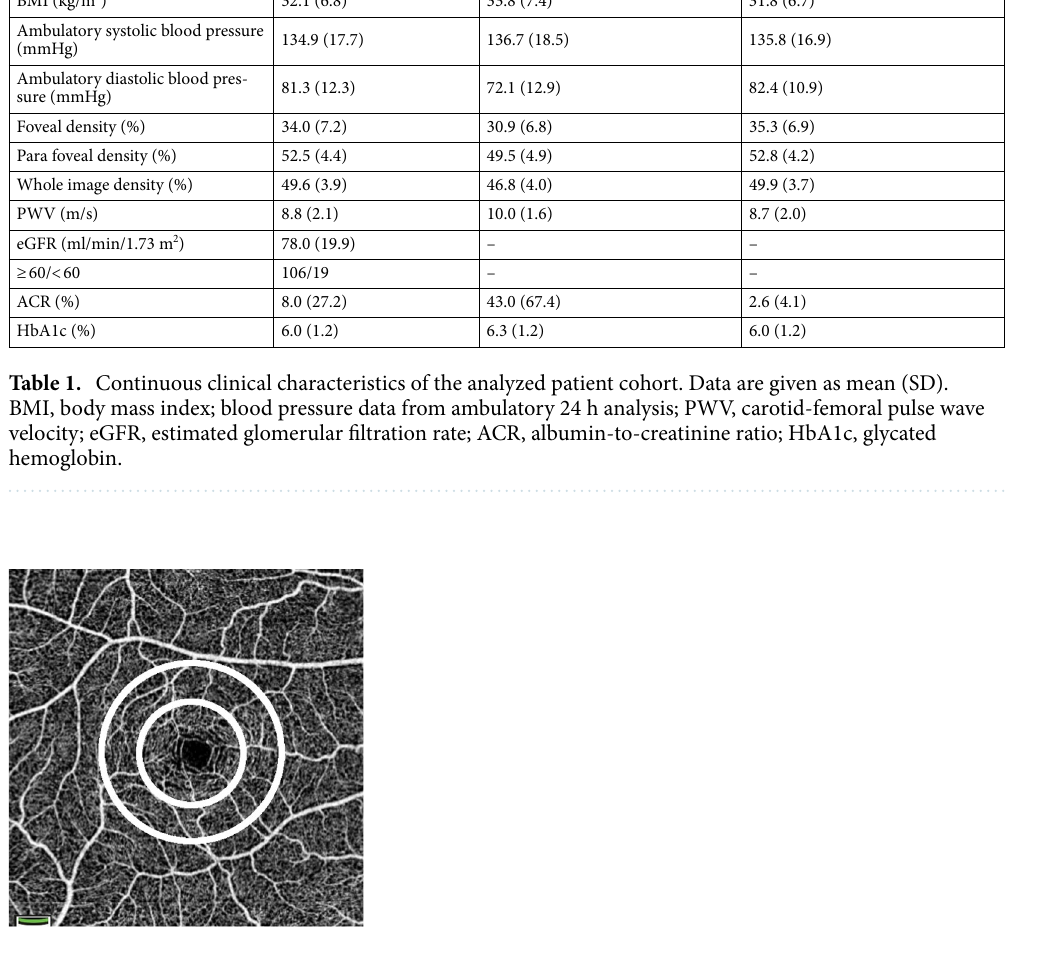
Figure 2. OCT angiogram of the left macula illustrating the regions of interest for retinal capillary density analysis. The central circular fovea region has a diameter of 1.5 mm, the parafovea ring reaches from 1.5 to 2.5 mm from the foveal center and the whole image is a 6 mm square centered on the